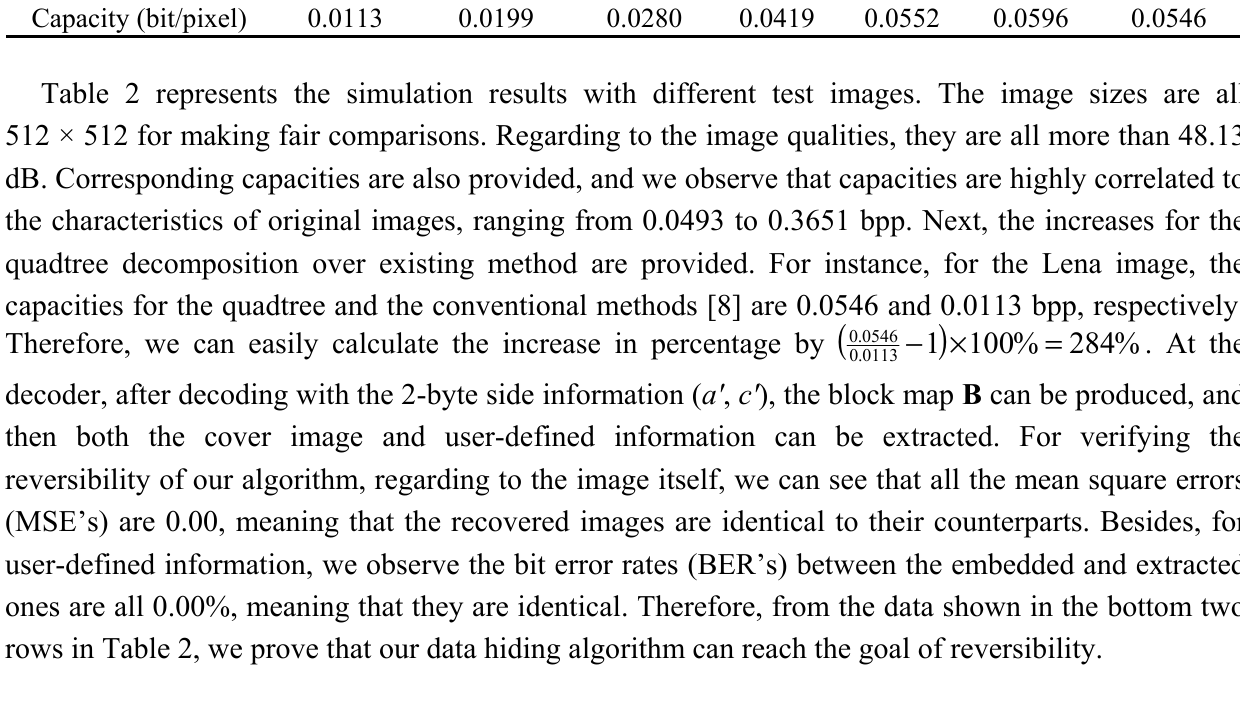
Table 2. Comparisons of performances of test images, in alphabetical order, with conventional